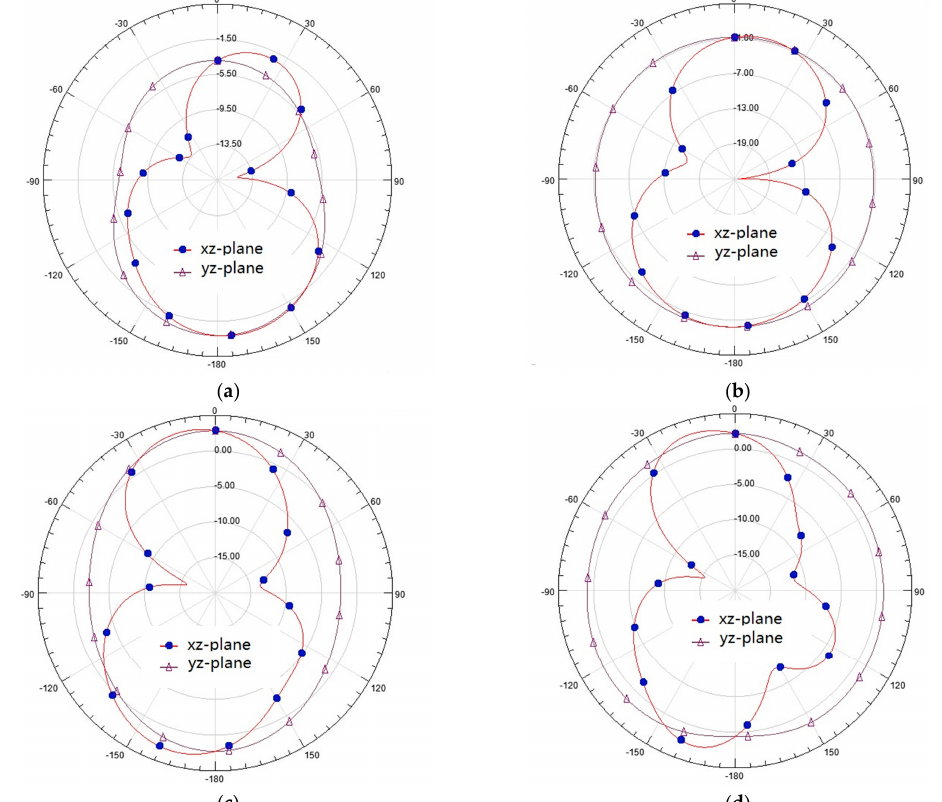
Figure 14. Simulation radiation patterns at ( a ) 2.5 GHz, ( b ) 4.5 GHz, ( c ) 7.0 GHz, and ( d ) 8.6 GHz frequencies.